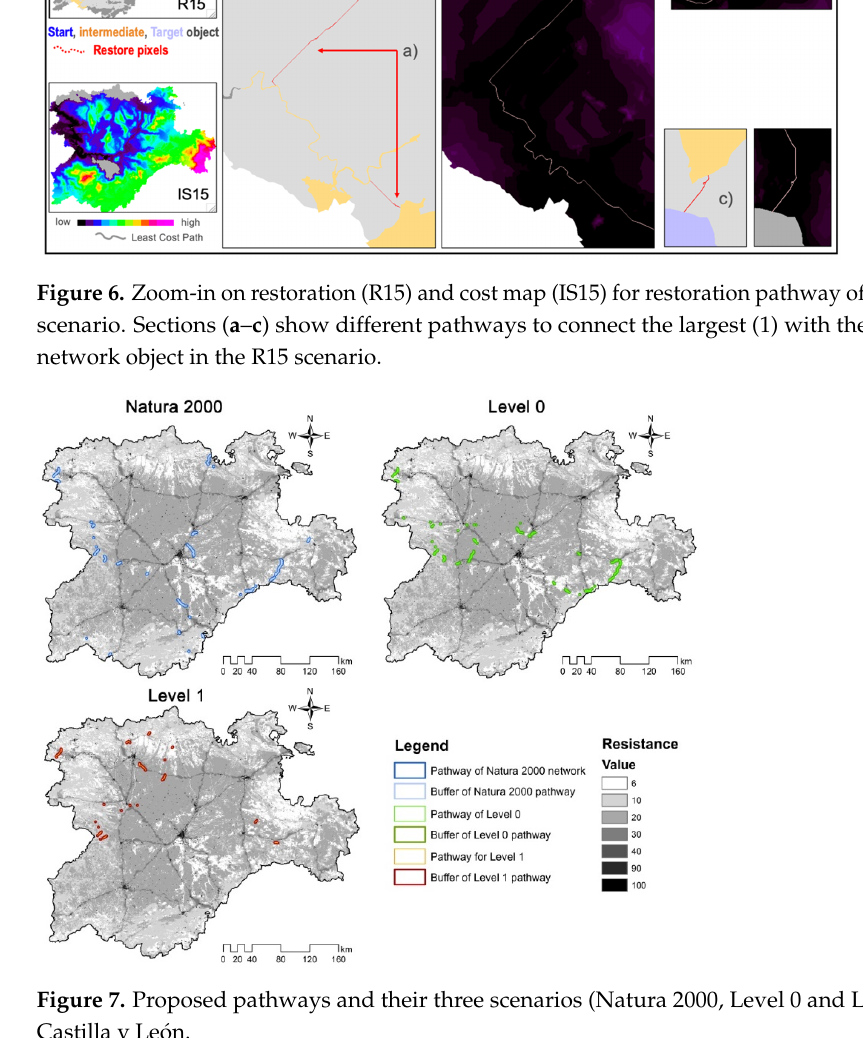
Figure 7. Proposed pathways and their three scenarios (Natura 2000, Level 0 and Level 1) zones in Castilla y León.